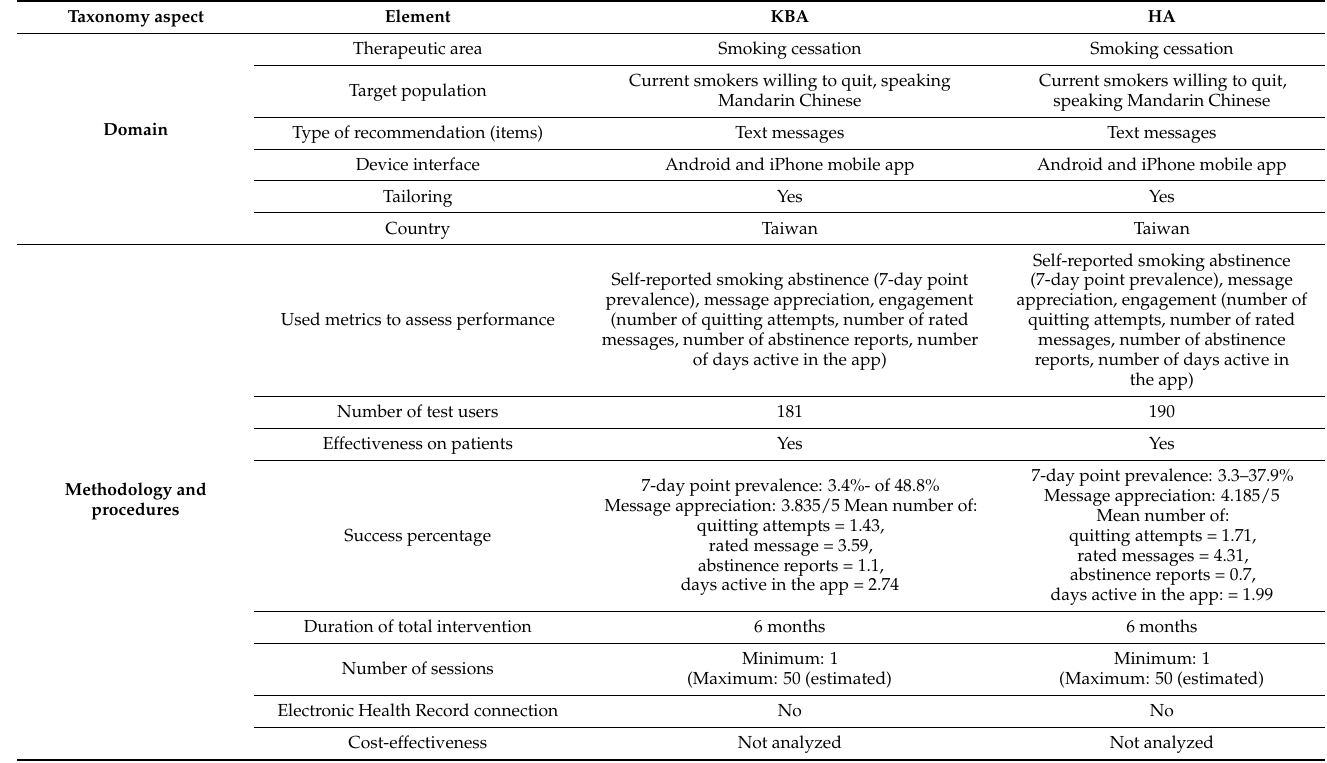
Table 6. Classification for both health recommender systems (cid:48)